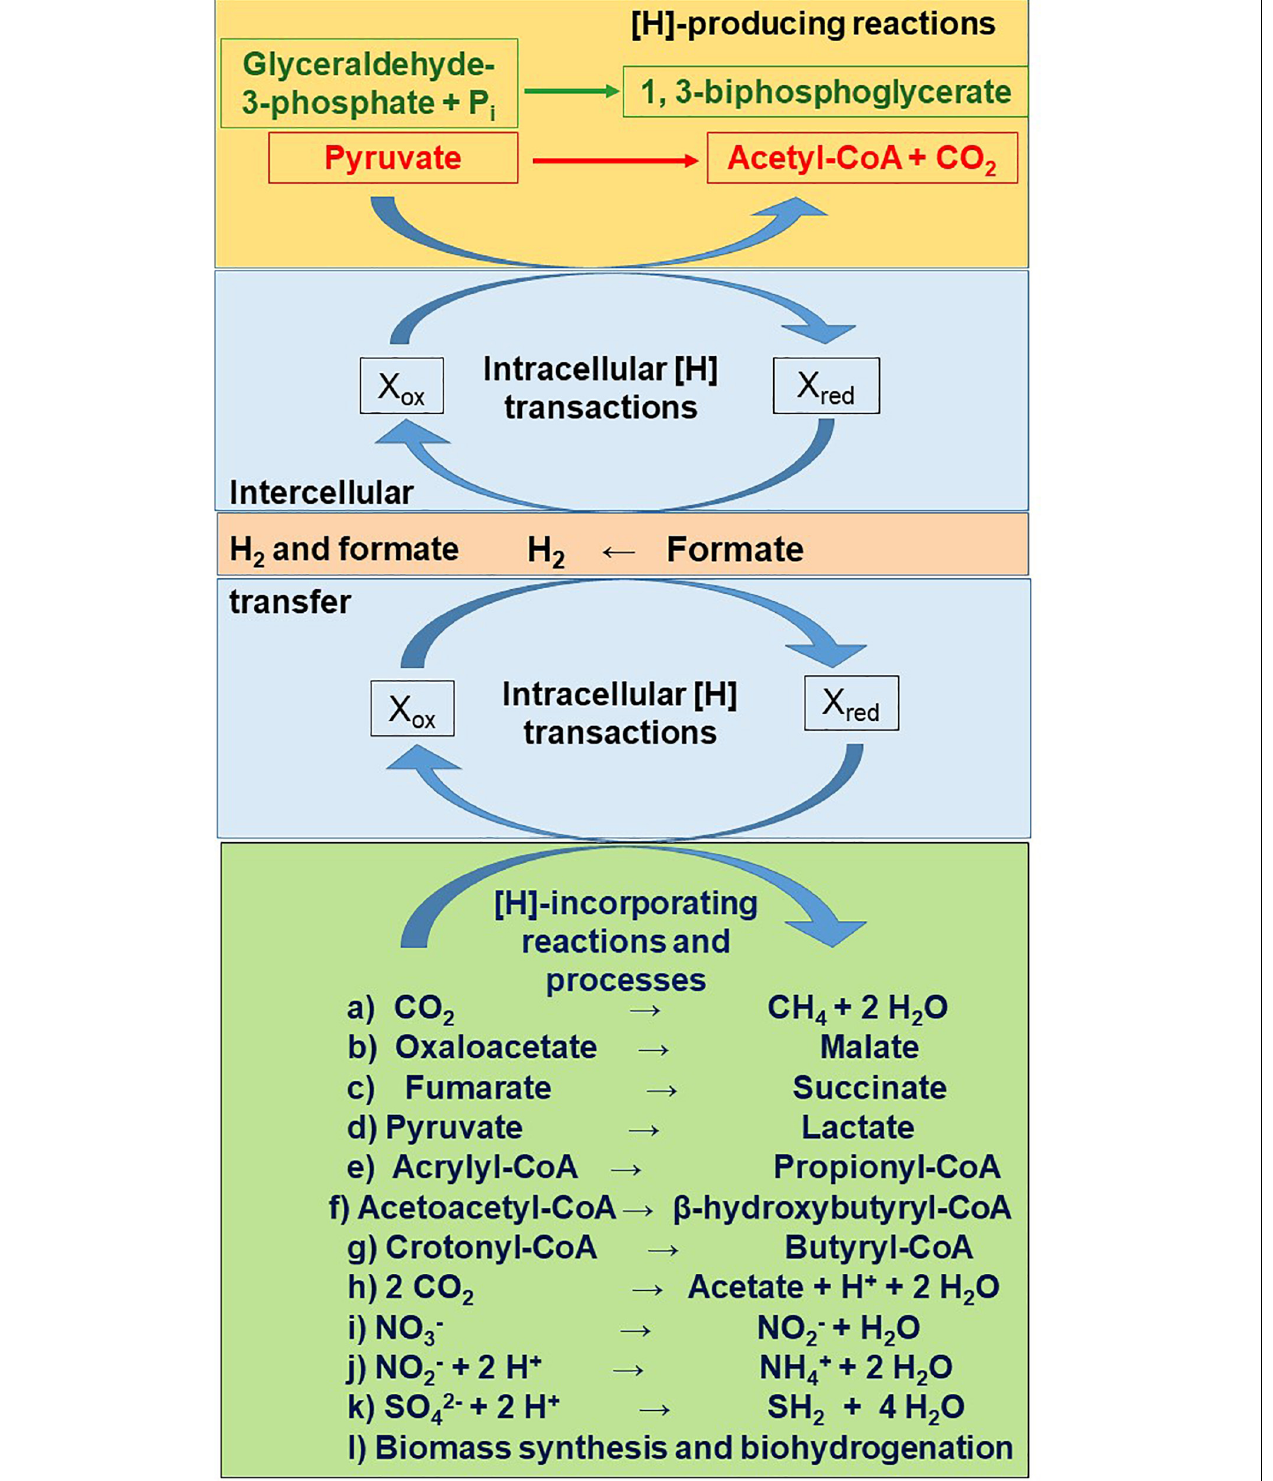
FIGURE 2 | Main reactions releasing (orange rectangle) and incorporating (green rectangle) metabolic hydrogen ([H]), as connected by intracellular (sky blue rectangle) and intercellular (salmon rectangle) metabolic hydrogen transactions. The stoichiometry of production and incorporation of reducing equivalents is not